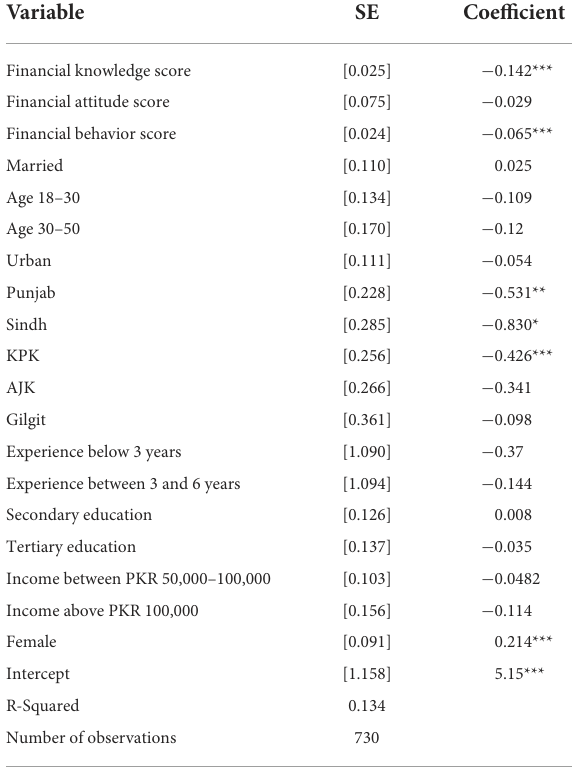
TABLE 4 Financial capability components effect on stress amid